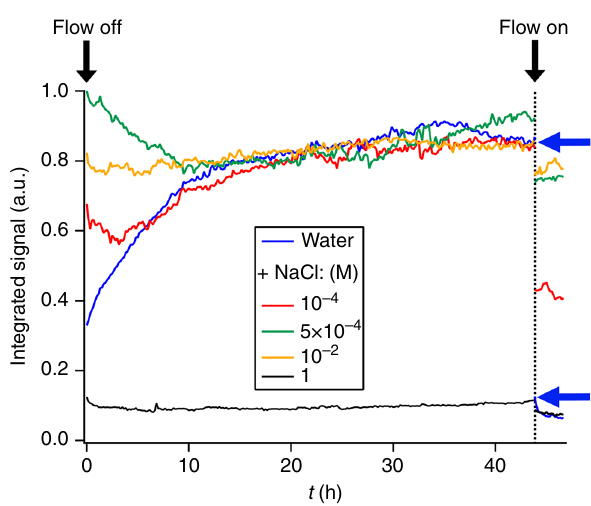
Fig. 3 Integrated SFG signal. Integrated O – H-stretch SFG signal of the silica/water interface at equilibrium ( t >12 h) and under fl ow conditions with different bulk sodium chloride concentrations. The error bars represent the 2 σ variation from the corresponding average